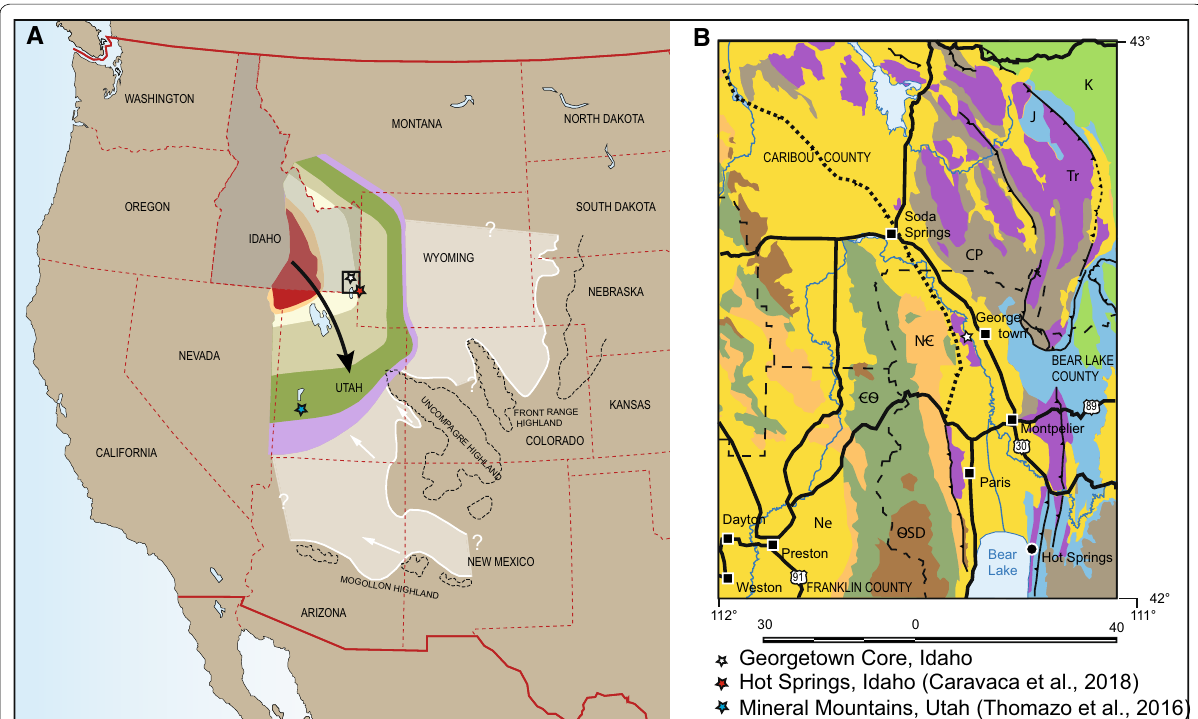
Fig. 1 a Map of the Western USA (based on Google maps). The Sonoma basin is indicated after Caravaca et al. (2018), direction of the Smithian transgression after Vennin et al. (2015) and Brayard et al. (2013). Extent of the Moenkopie and Chugwater groups (pale area) as well as sediment transport directions after Stewart et al. (1972). b Geological map of the Bear Lake area based on Lewis et al. (2012) (Geological map of Idaho